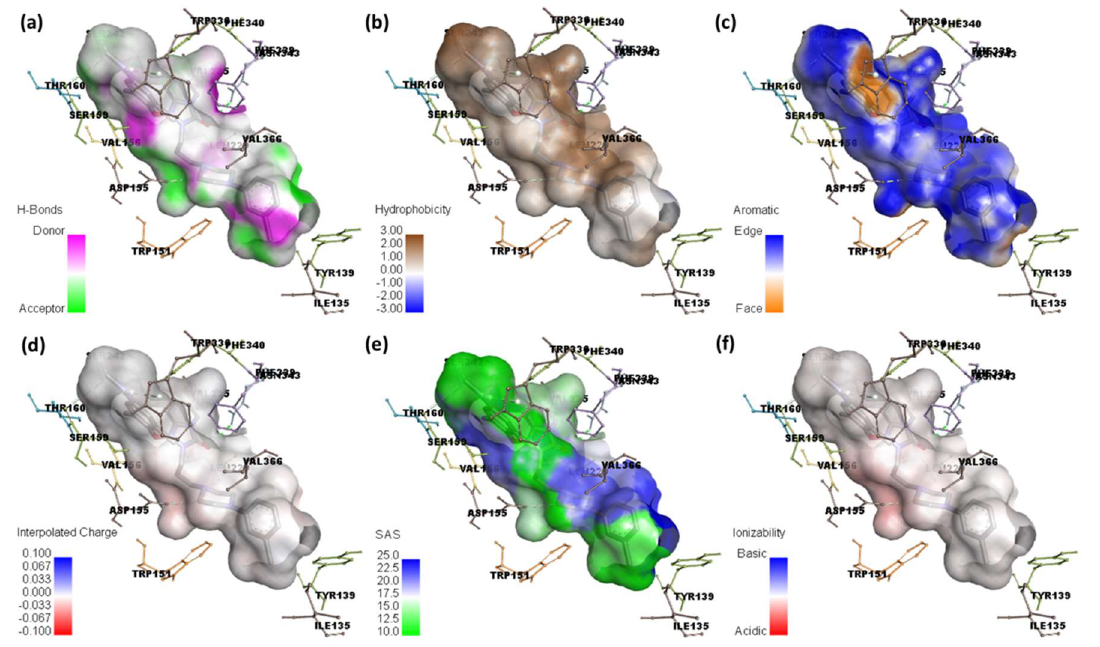
Figure 12. Molecular docking analysis ( a ) hydrogen binding surface, ( b ) hydrophobic surface, ( c ) aromatic surface, ( d ) interpolated charge, ( e ) solvent accessible surface, and ( f ) ionizability surface; between serotonin and [(TZD)(DCQ)] complex.